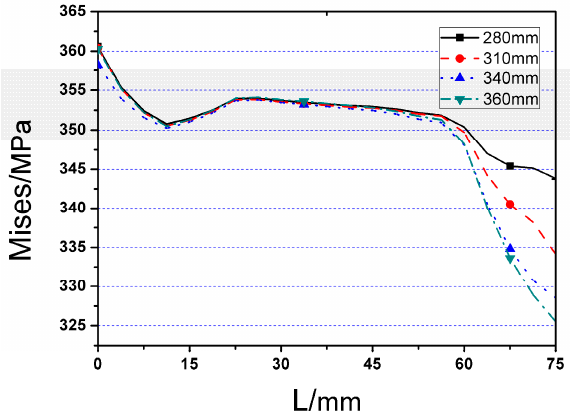
Figure 14. The Von Mises stress distribution along welding seam length (start from edge to middle of welding seam) of RB series FE joint models.